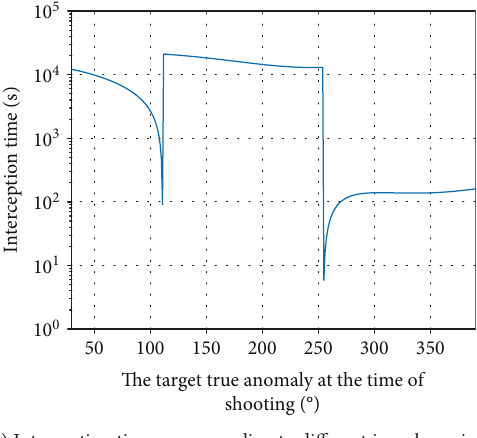
(c) Interception time corresponding to di ff erent impulse points Figure 8: Tangent impulse interception solution at di ff erent impulse points in the target orbit